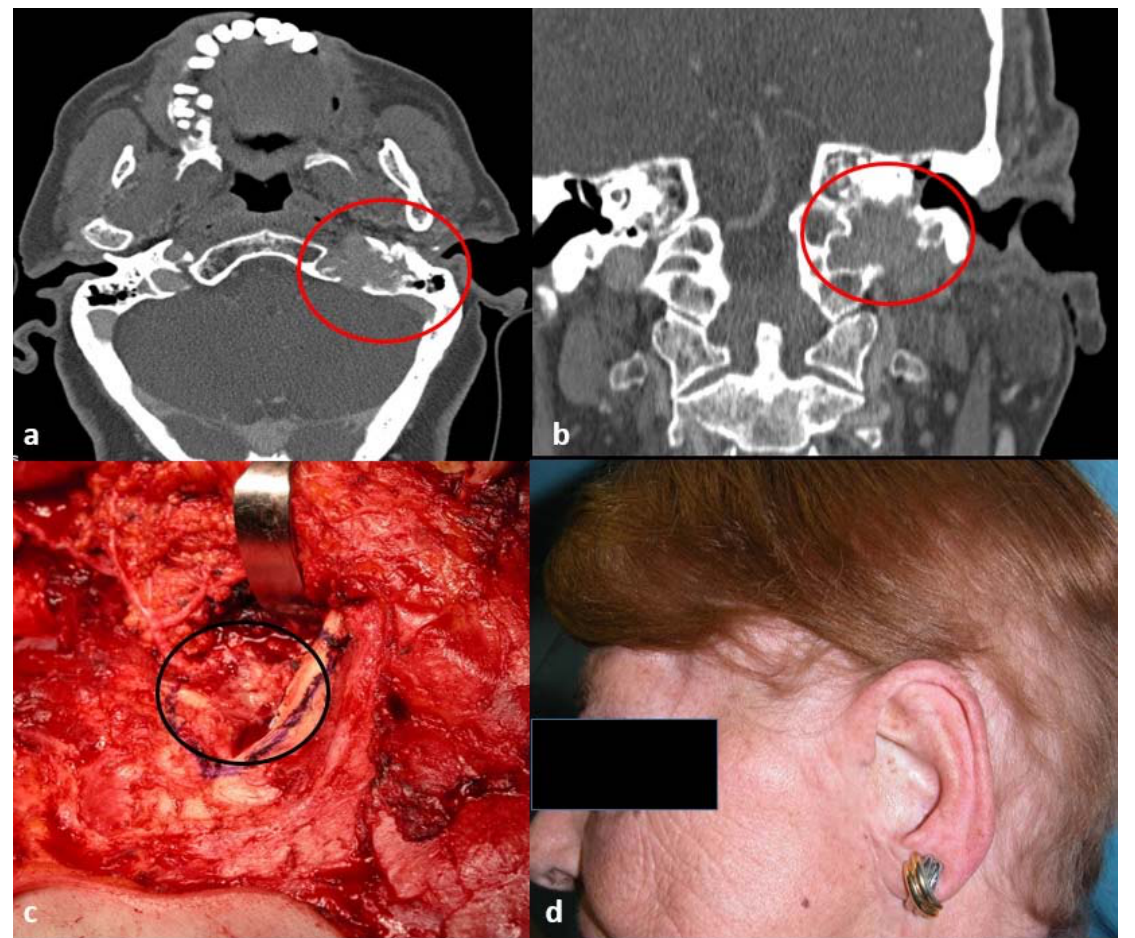
Figure 1. ( a ) Preoperative computed tomography (CT) scan axial view; the red circle indicates the tumor; ( b ) preoperative Figure 1. Preoperative, intraoperative, and post-operative images. ( a ) Preoperative computed tomography (CT) scan CT scan coronal view; the red circle indicates the tumor; ( c ) intraoperative view, the black circle indicates the tumor; ( d ) axial view; the red circle indicates the tumor; ( b ) preoperative CT scan coronal view; the red circle indicates the tumor; 1 ‐ year post ‐ operative clinical evaluation. ( c ) intraoperative view, the black circle indicates the tumor; ( d ) 1-year post-operative clinical evaluation. Table 1. Patients demographics, tumor and treatment characteristics.